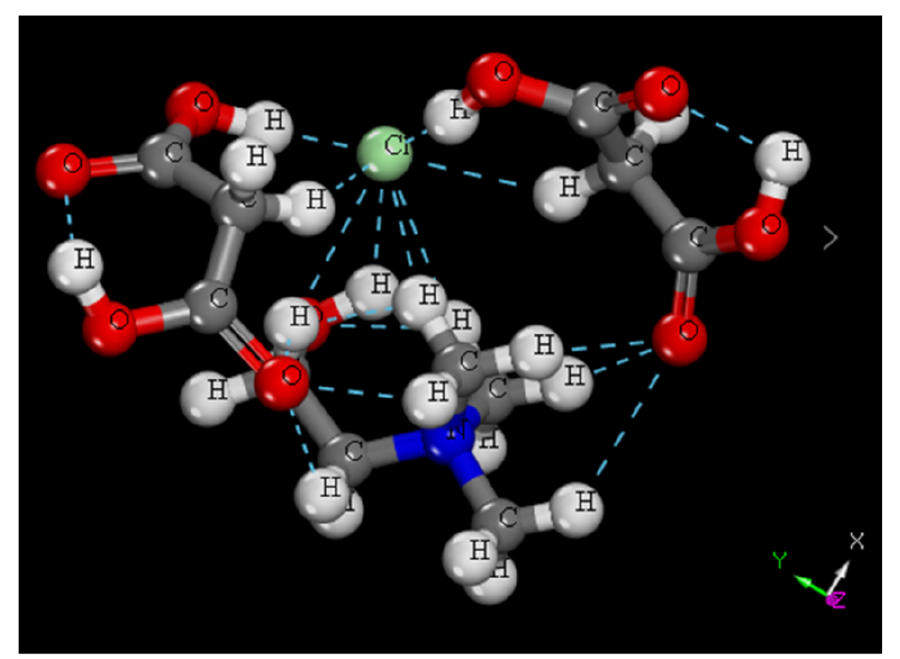
Figure 3. Stable configuration of ChCl-2MA deep eutectic